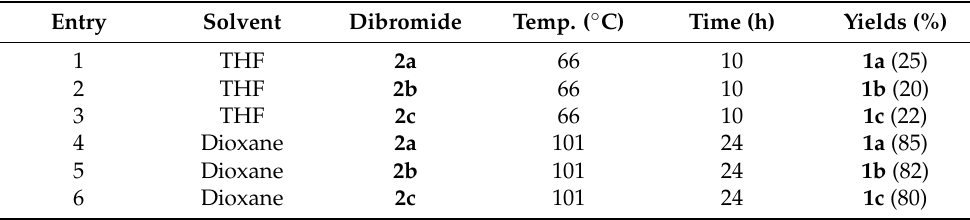
Table 1. Suzuki–Miyaura coupling of 4,7-dibromo-2,1,3-benzochalcogenadiazoles 2 ( a – c ) with 4,6-